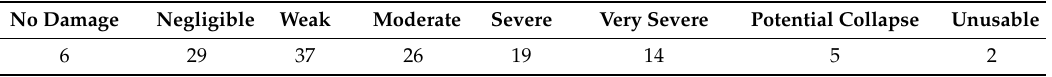
Table 4. Classification of the structures of Coloretta a ff ected by landslide-induced damage. No Damage Negligible Weak Moderate Severe Very Severe Potential Collapse